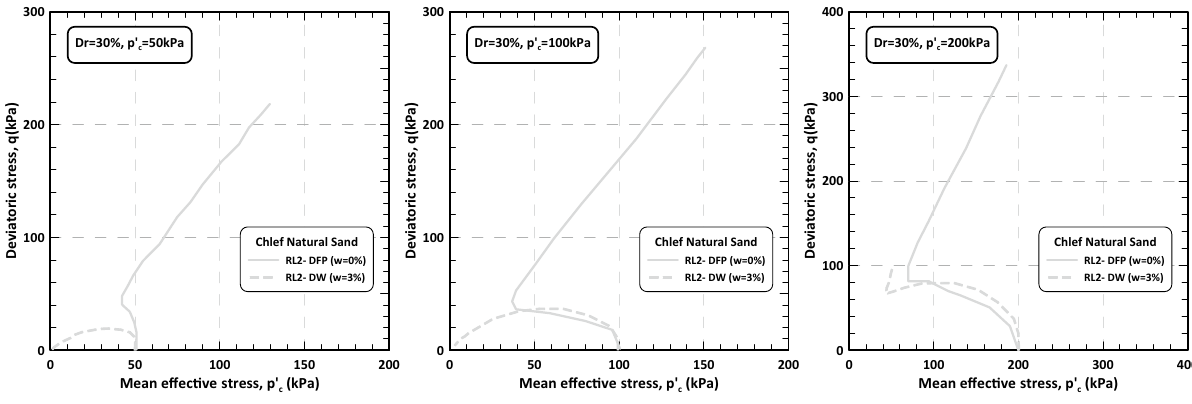
Fig. 13 Effective stress path curves of sand unreinforced and reinforced with two layersof geotextile under different confining pressures: a p ′